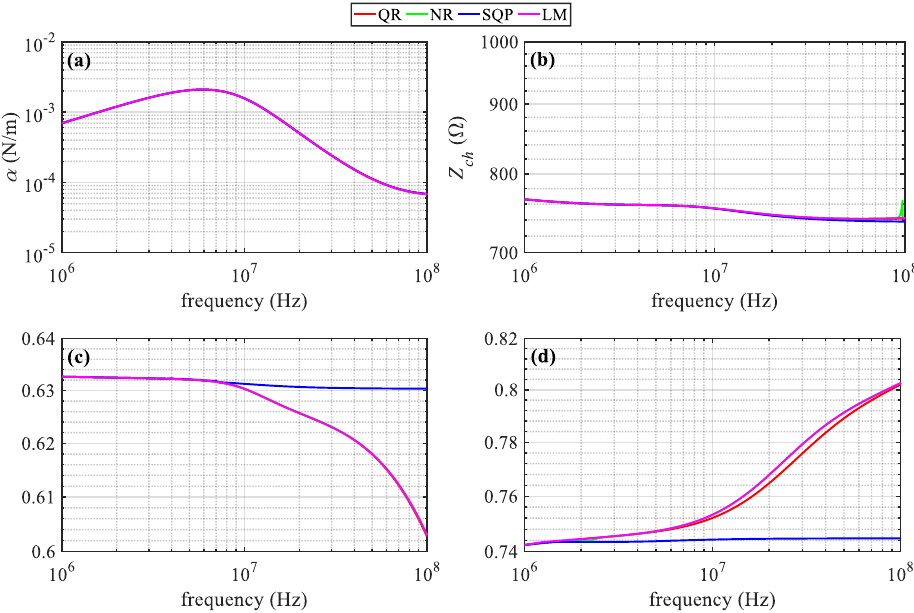
Figure 23. Ground mode ( a ) attenuation constant, ( b ) characteristic impedance magnitude and magnitude of the ( c ) element (1,1) and ( d ) element (1,2) of the transformation matrix for different methods. BB range.